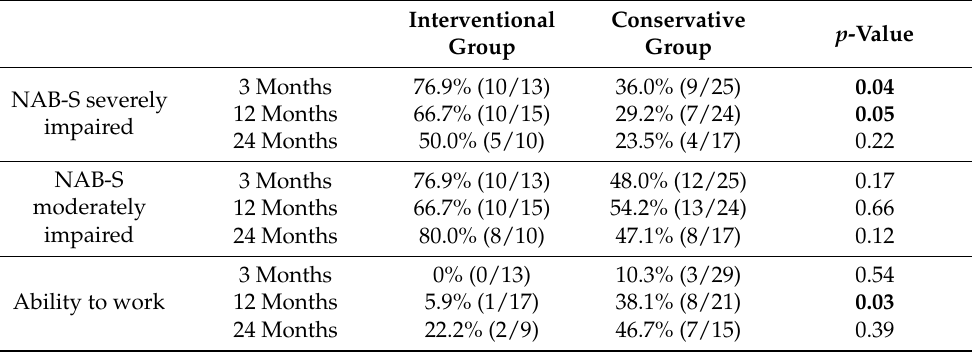
Table 3. Neuropsychological outcome assessed by NAB-S. NAB-S: Screening module of the Neu- ropsychological Assessment